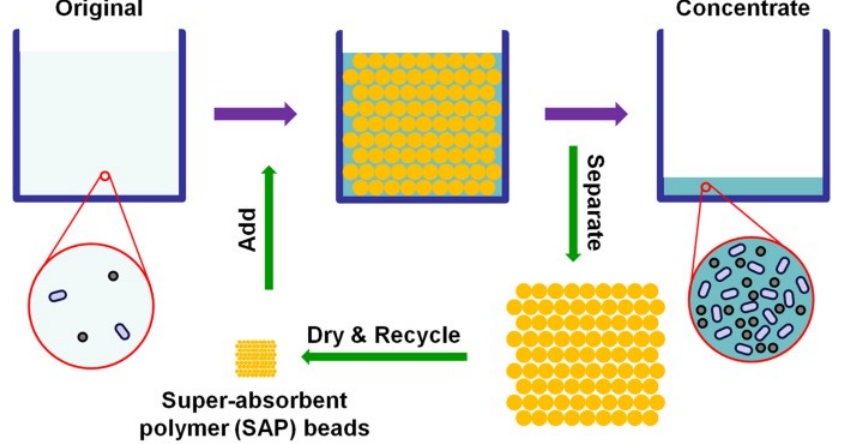
Figure 1. Schematic diagram of super-absorbent polymer (SAP) beads preparation [46]. The absorbed water is then released as the soil dries, making it available to the plants [4]. The swelling of the polymer in the soil improves porosity, air capacity, and CEC while decreasing the infiltration rate [47].